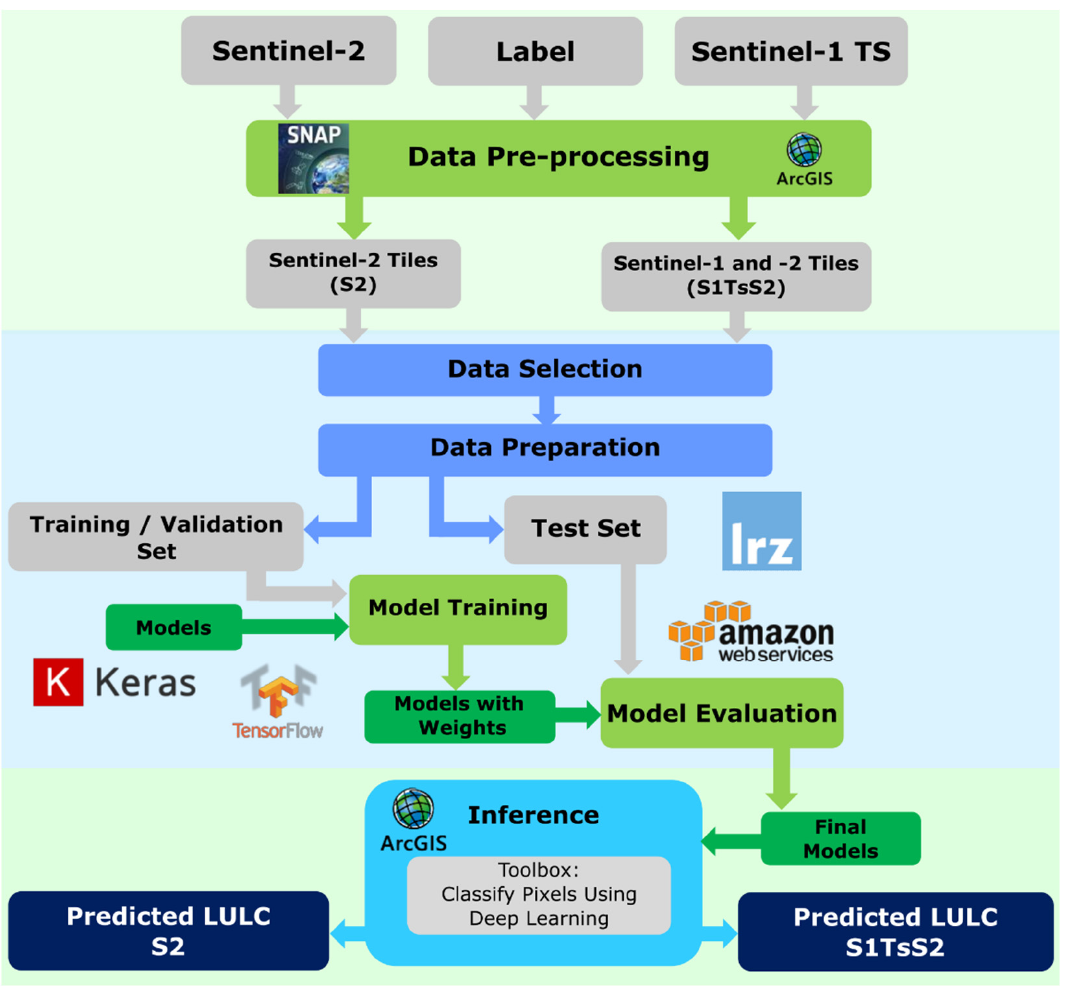
Figure 1. The global workflow of the LULC classification process with the tools and technologies used at each step.